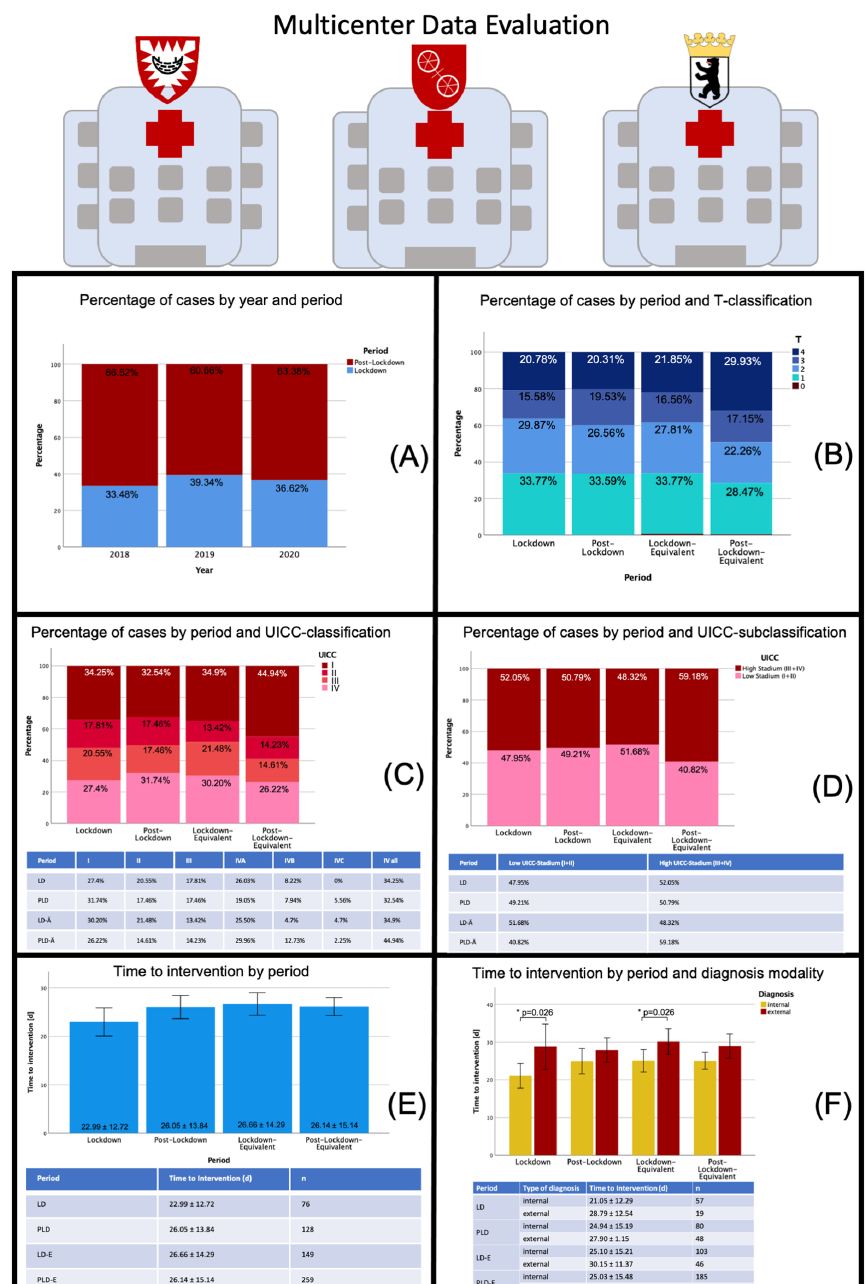
Figure 1. Data sheet multicenter data evaluation: Distribution of patients with oral malignant lesions by different periods, distribution of tumor stages (T-classification, UICC-classification) and time to intervention during the different periods.